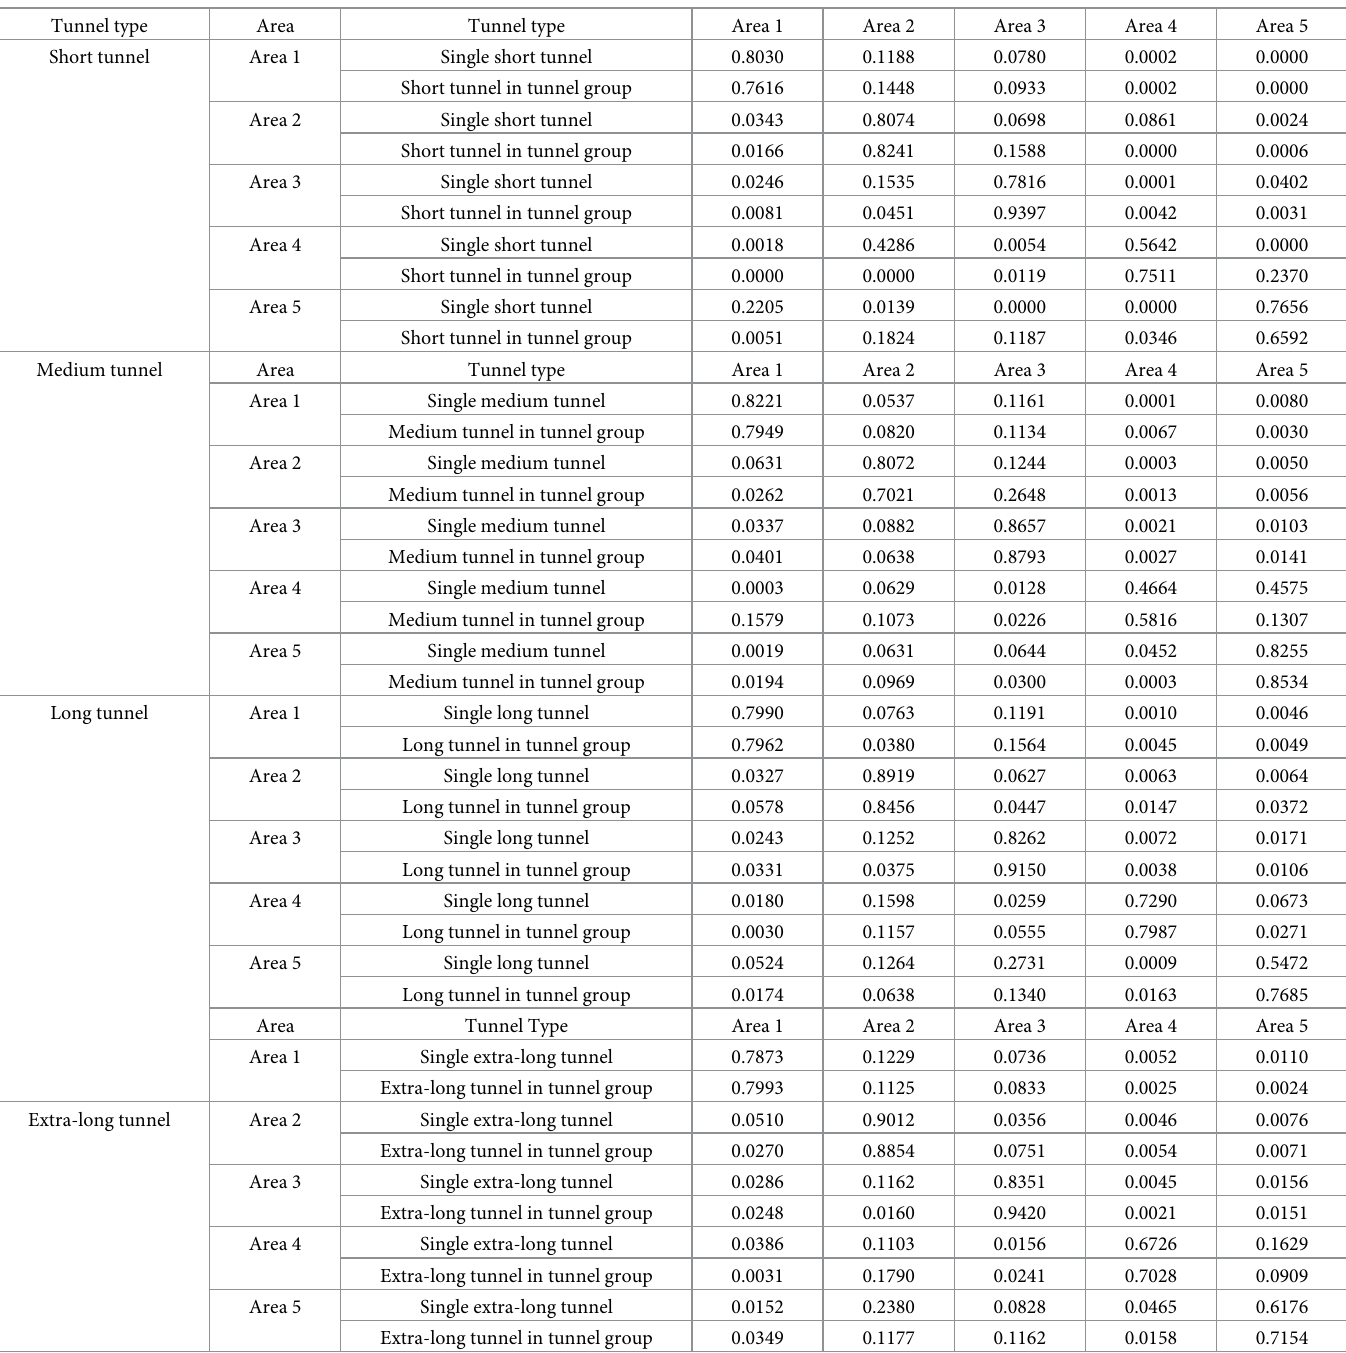
Table 3. Two-step transition probability matrix of different type